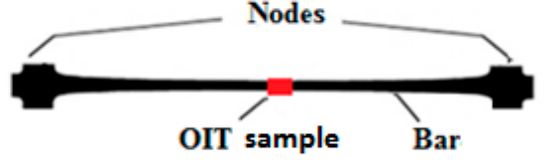
Figure 4. Sampling locations of oxidation induction time OIT test samples.